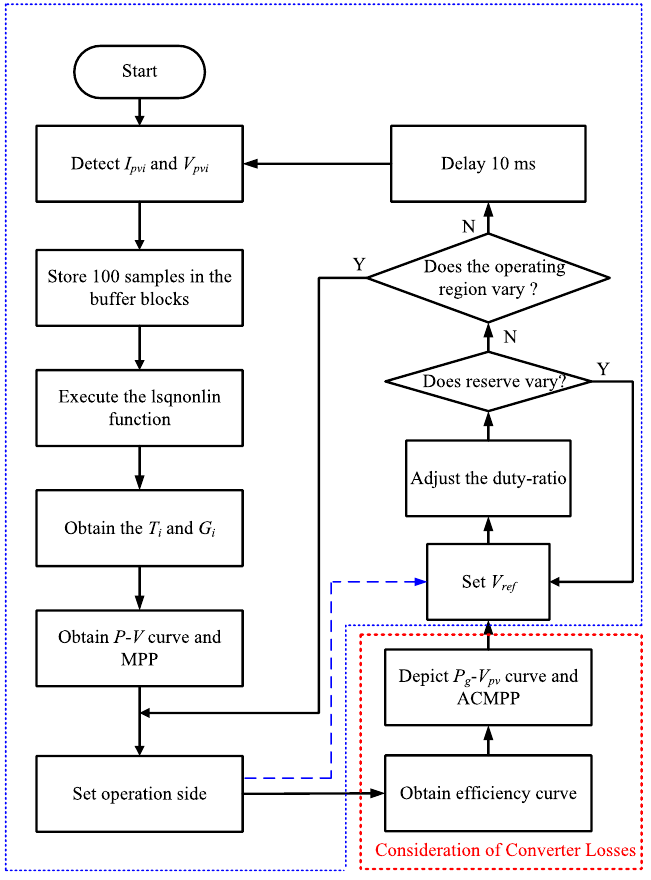
Figure 17. Control scenario of proposed power curtailment method [17] (remarked with blue dashed line) with converter losses (remarked with red dashed